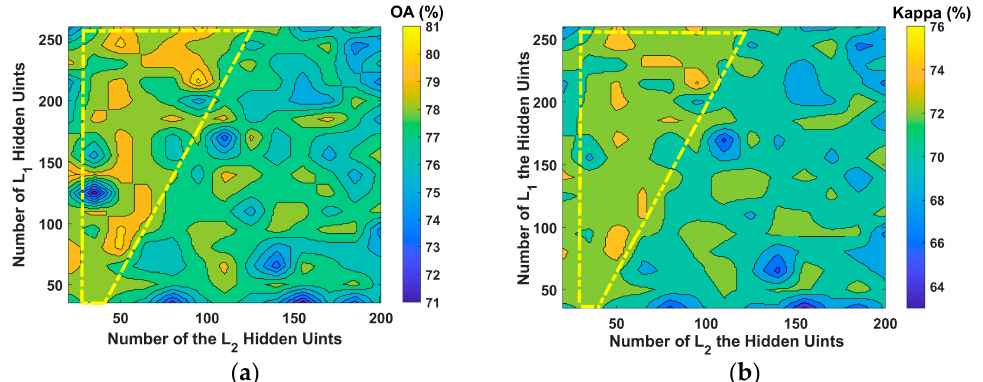
Figure 11. Classification accuracies using S-SAEs with different hidden units: ( a ) OA map and ( b ) kappa map.